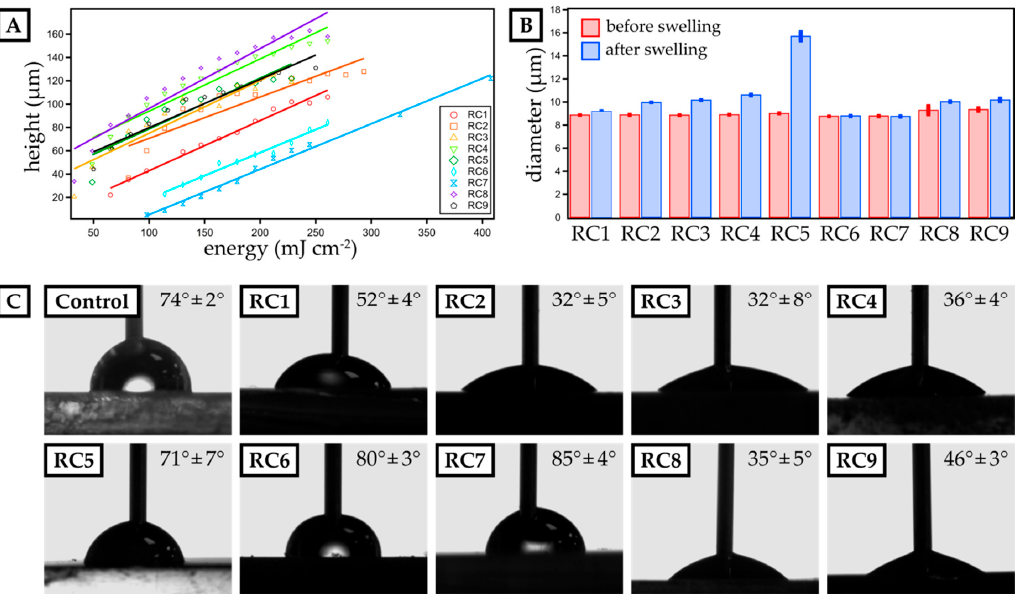
Figure 1. Characterization of dose calibration as well as swelling behavior and surface contact angle of micro-stereolithography (µSL)-printed, disk-shaped test objects. ( A ) The height of single 3D-printed layers is plotted against the exposure energy for resin compositions RC1 to RC9. A linear fit visualizes the data trend and is employed to calculate the exposure energy required for a distinct layer thickness. ( B ) The diameter of 3D-printed discs (three prints per resin) is measured before and after swelling in phosphate-buffered saline (PBS) buffer for 24 h for each resin composition. ( C ) The advancing contact angle of water is measured for 3D-printed layers made from resins RC1 to RC9. Polystyrene (PS) serves as a reference surface. The mean contact angle and the deviation for three individual experiments are included.